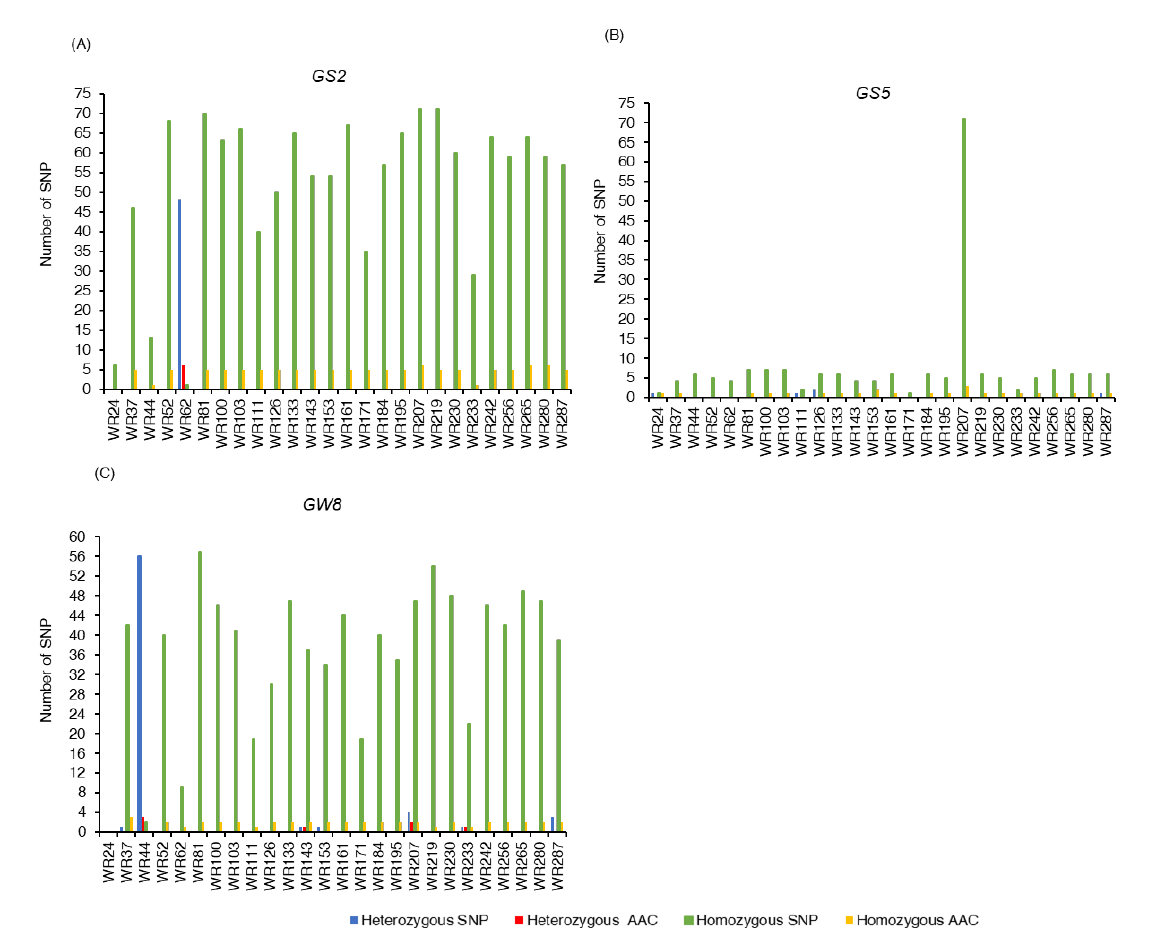
Figure 4. Variation of homozygous and heterozygous single nucleotide polymorphisms (SNPs) and corresponding amino acid changes (AAC) of three grain size loci in 26 Australian wild rice samples: ( A ) Total number of homozygous and heterozygous single nucleotide polymorphisms (SNPs) and corresponding amino acid changes (AAC) of GS2 ( GRAIN SIZE 2 ); ( B ) Total number of homozygous and heterozygous single nucleotide polymorphisms (SNPs) and corresponding amino acid changes (AAC) of GS5 ( GRAIN SIZE 5 ); ( C ) Total number of homozygous and heterozygous single nucleotide polymorphisms (SNPs) and corresponding amino acid changes (AAC) of GW8 ( GRAIN WIDTH 8 ).